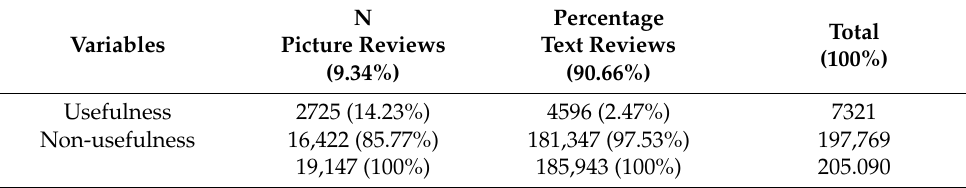
Table 4. Distribution of review